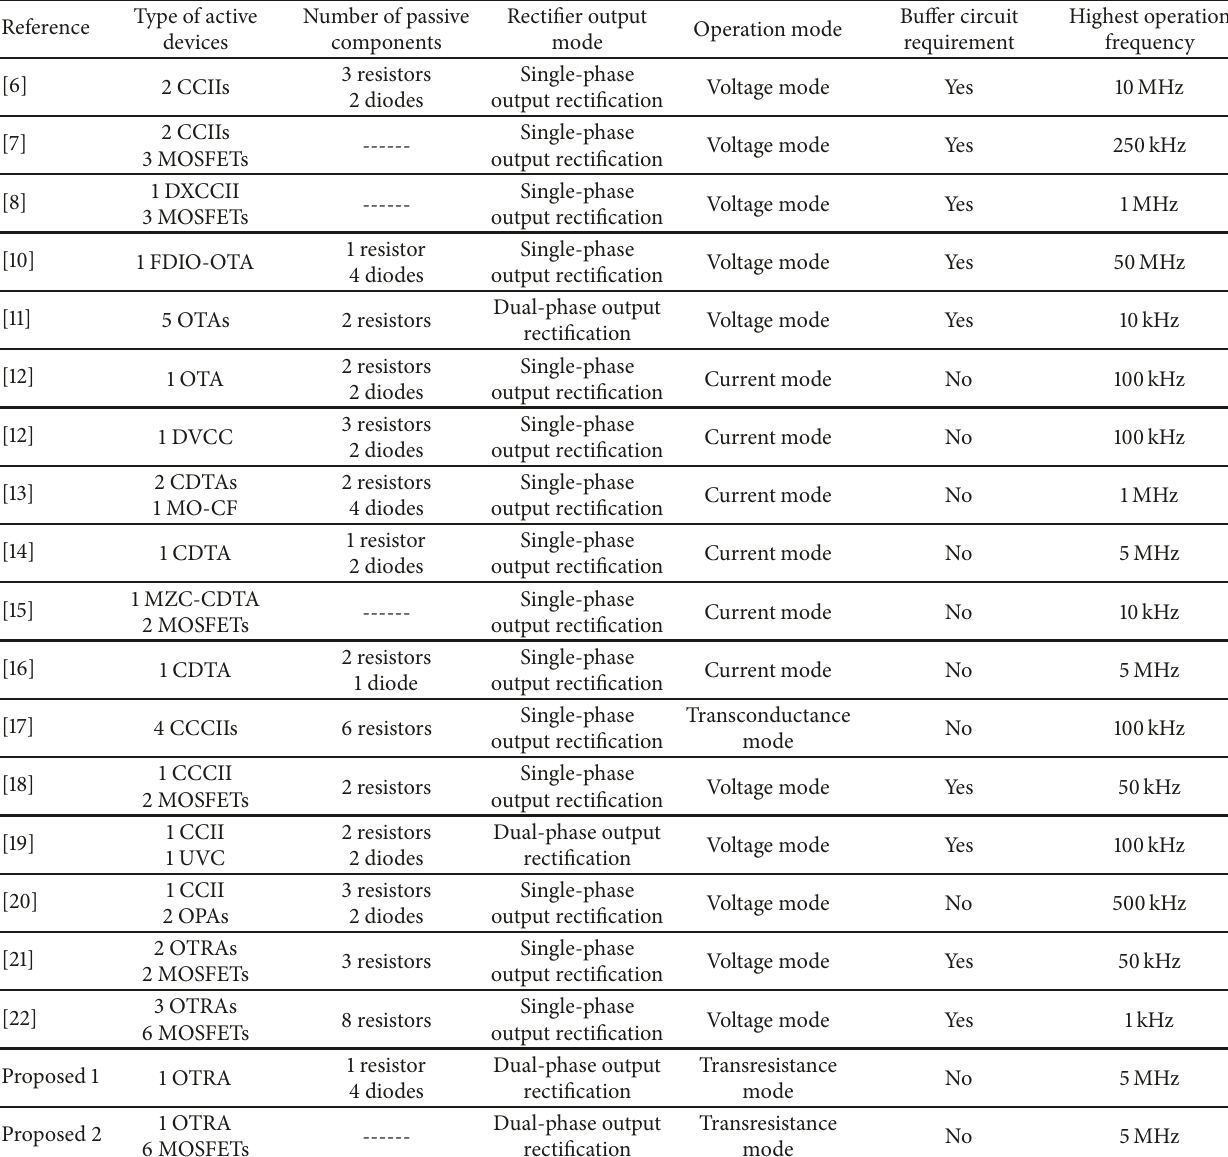
Table 1: Comparisons among various precision full-wave